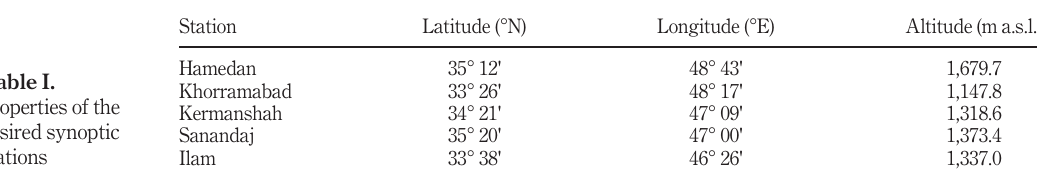
Table I. Properties of the desired synoptic